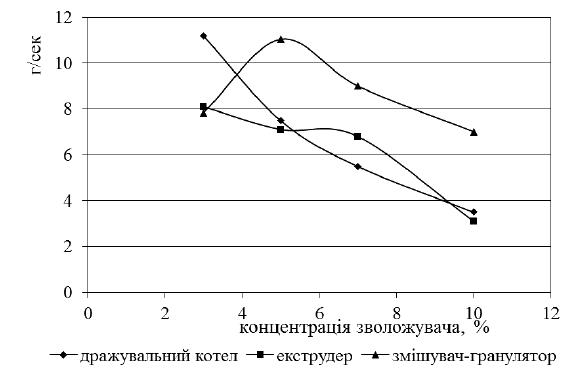
Рис. 6. Плинність гранул зволожених розчином